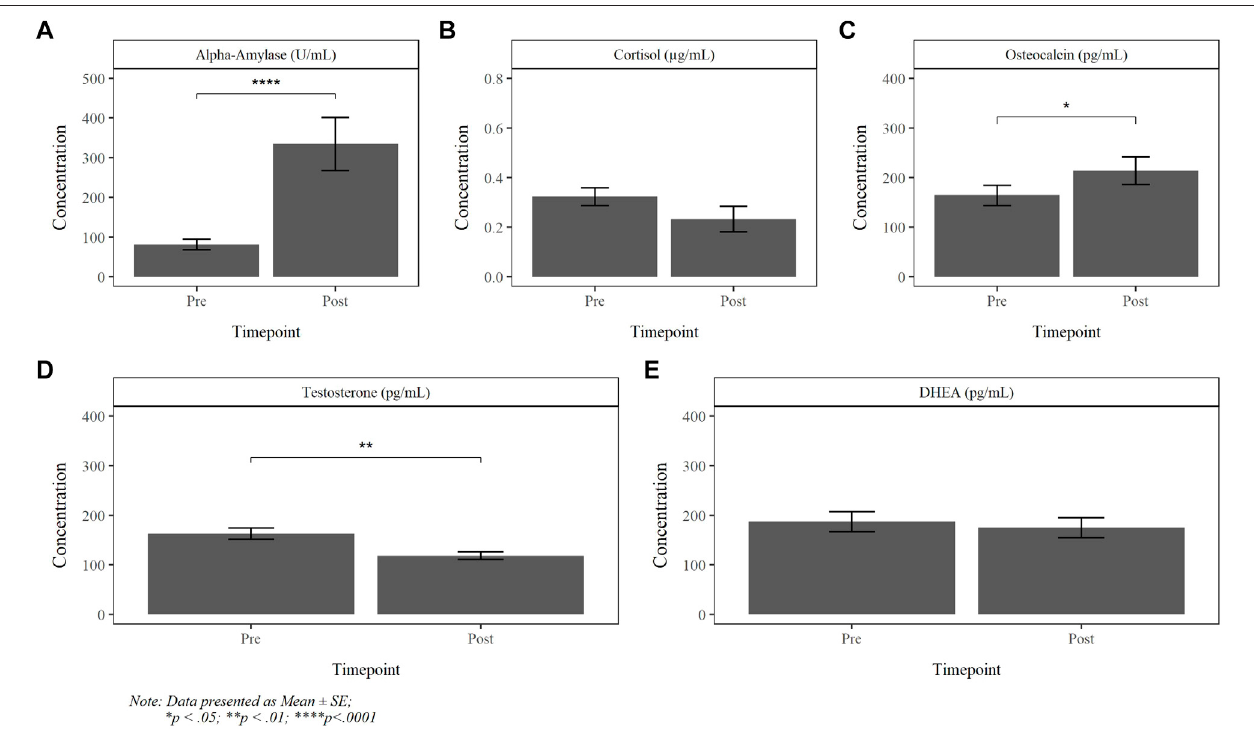
FIGURE 5 | Absolute pre- and post-dive concentration of alpha-amylase (A) , cortisol (B) , osteocalcin (C) , testosterone (D) and DHEA (E) .